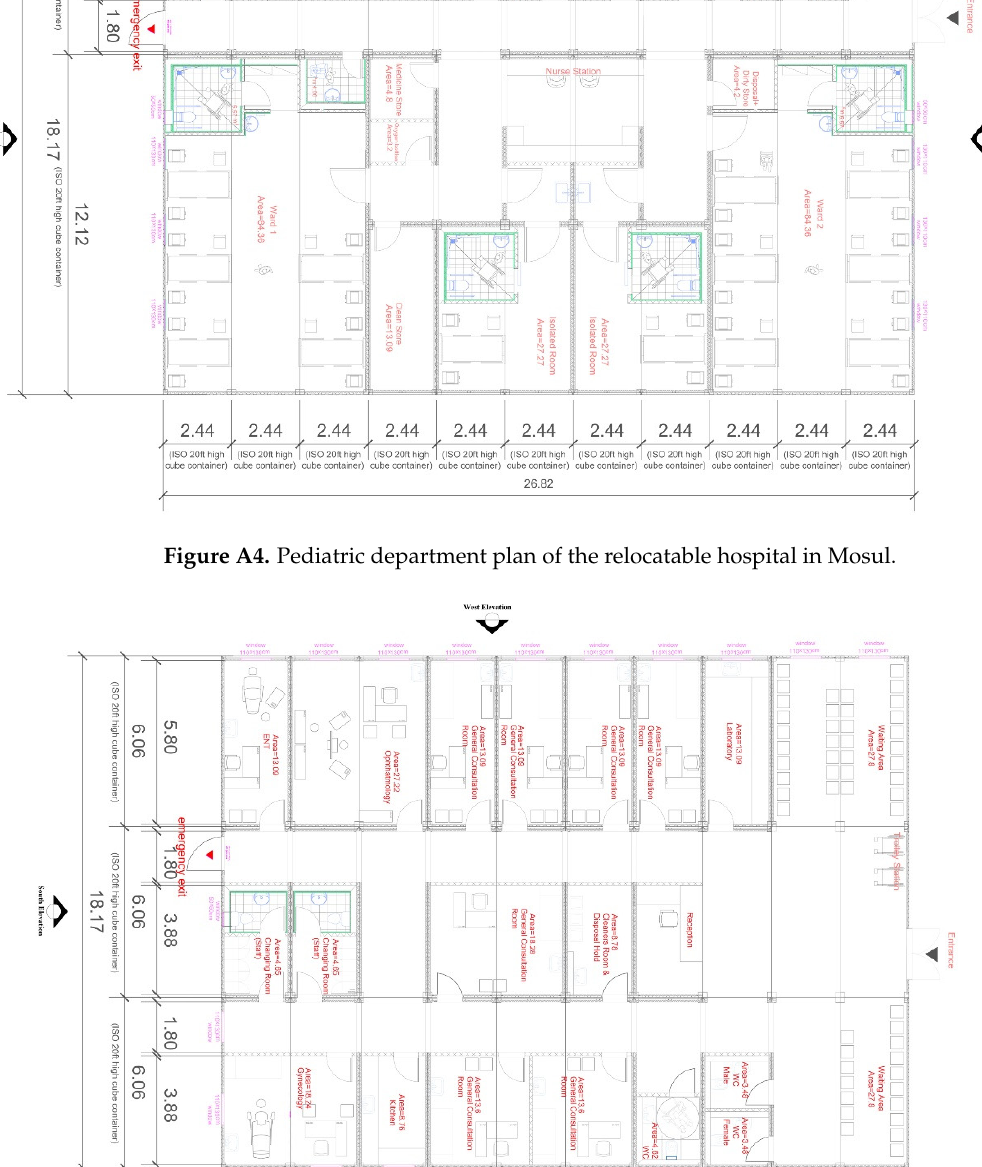
Figure A5. Outpatient department plan of the relocatable hospital in Mosul.